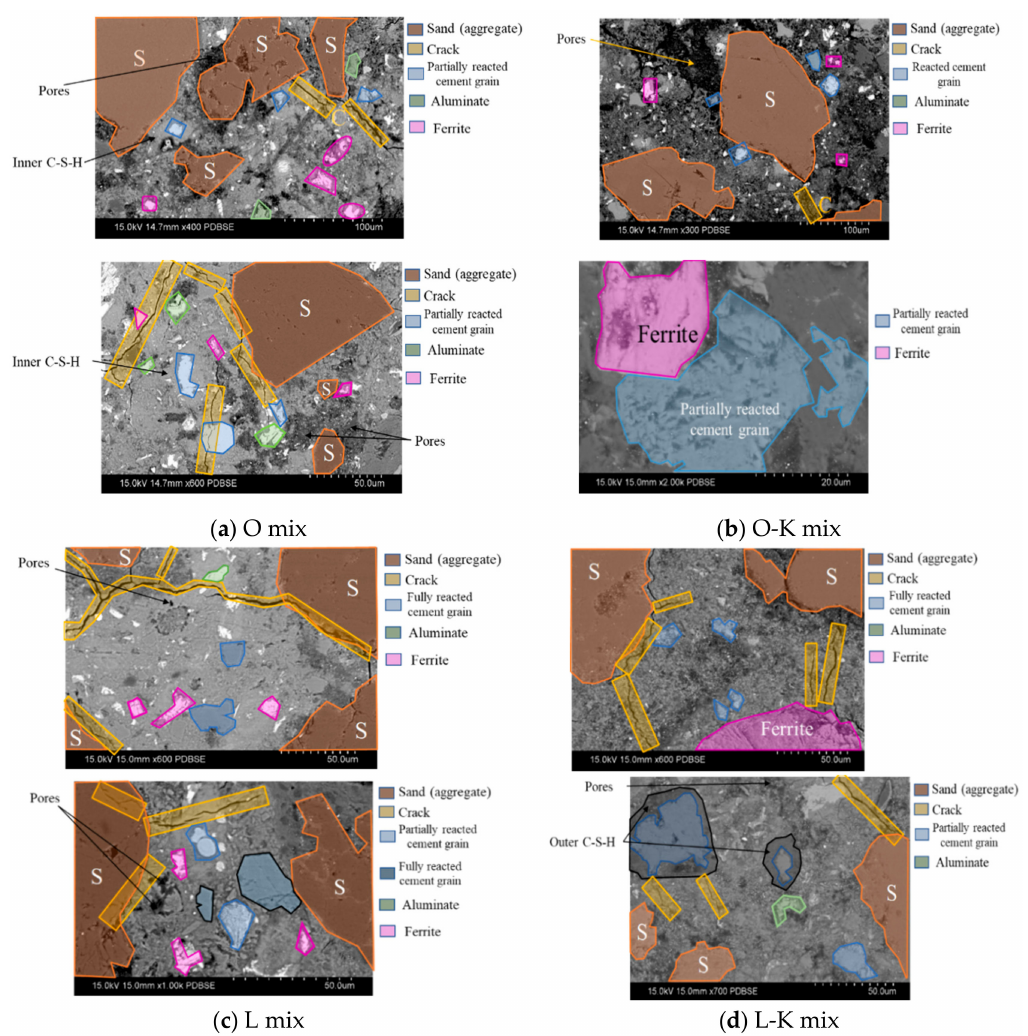
Figure 4. BSEM images of polished cementitious composite sections with and without CWA ( a ) O mix ( b ) O-K mix ( c ) L mix ( d ) L-K